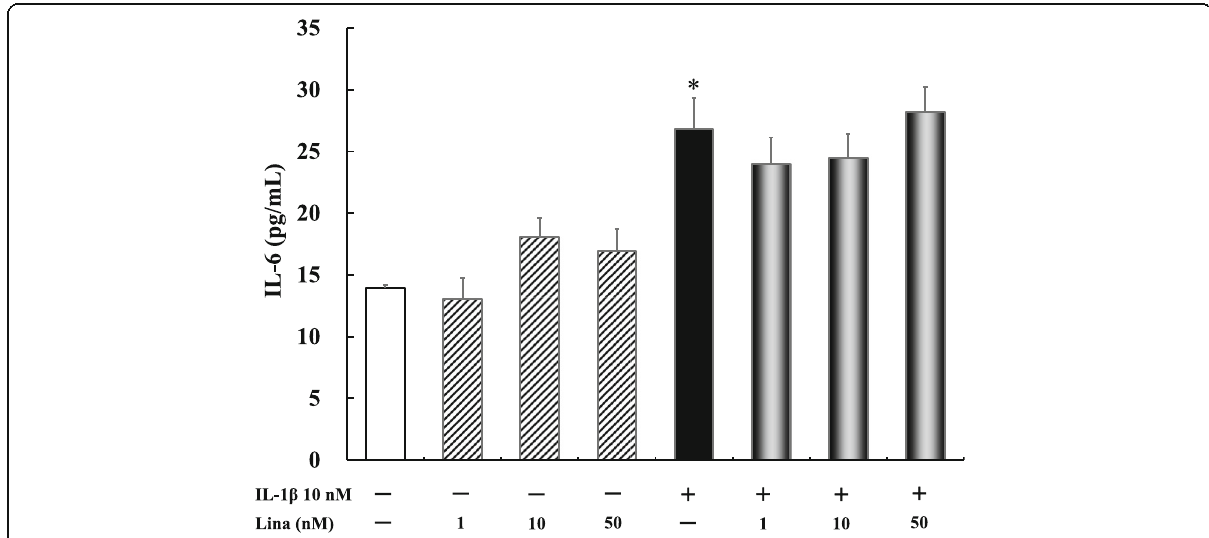
Fig. 5 Effects of linagliptin treatment on IL-1 β -induced IL-6 production after 24 h. Human U937 monocytes were treated with LPS and/or linagliptin. IL-6 levels in the supernatants were determined via ELISA after 24 h of treatment. * P <0.0001 vs. control. Lina,